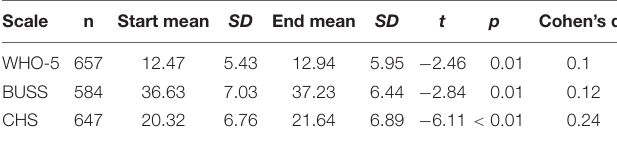
TABLE 2 | Descriptive statistics for main